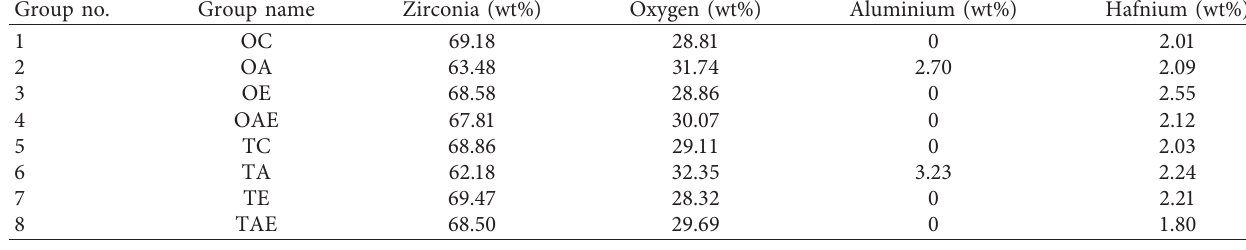
Table 4: Elemental composition in weight % of all the groups. Group